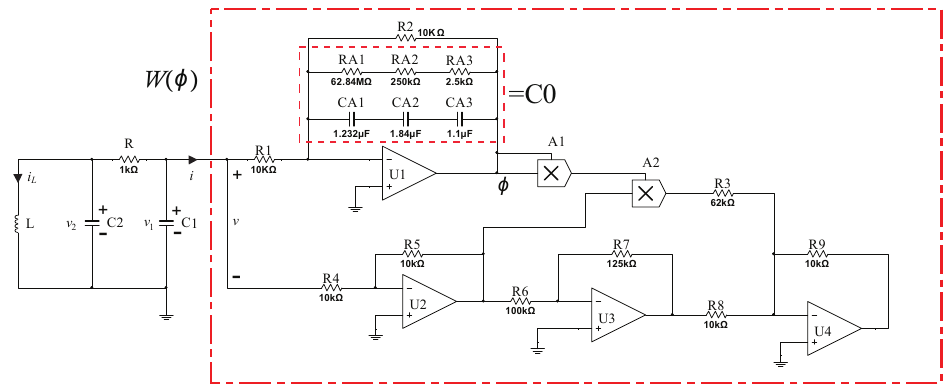
Figure 2. Fractional-order memristor chaotic circuit.